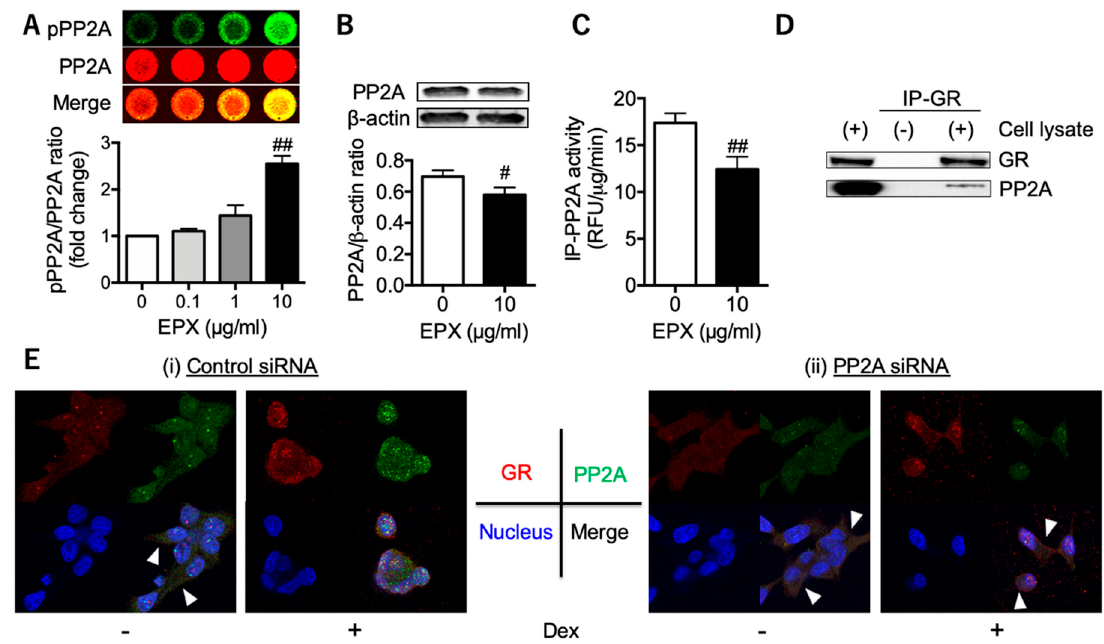
Figure 2. PP2A’s involvement in glucocorticoid receptor (GR) nuclear translocation. Phosphorylation levels of PP2A ( A ), PP2A protein expression ( B ), and activity ( C ) in human bronchial epithelial cells (BEAS-2B cells). BEAS-2B cells were co-incubated with recombinant eosinophil peroxidase (EPX) for 15 min ( A ) or 3 days ( B , C ). Data in A are expressed as the fold change relative to the vehicle. Values in A, B, and C represent the mean ± SEM values of four experiments: # p < 0.05, ## p < 0.01 (vs. vehicle). ( D ) GR and PP2A expression in whole cell extracts (left lane) and in GR-immunoprecipitates (right lane). ( E ) Dexamethasone (Dex)-induced GR nuclear translocation in BEAS-2B cells treated with siRNA. GR (red) with PP2A (green) translocated into the nucleus (blue) in the control [right panels in (i)], whereas GR with PP2A remained in the cytoplasm even after the addition of Dex in cells with reduced PP2A by siRNA (right panels in (ii)). The arrow heads indicate GR with PP2A in the cytoplasm. Images were obtained using a Carl Zeiss LSM700 confocal microscope (400 × objective).